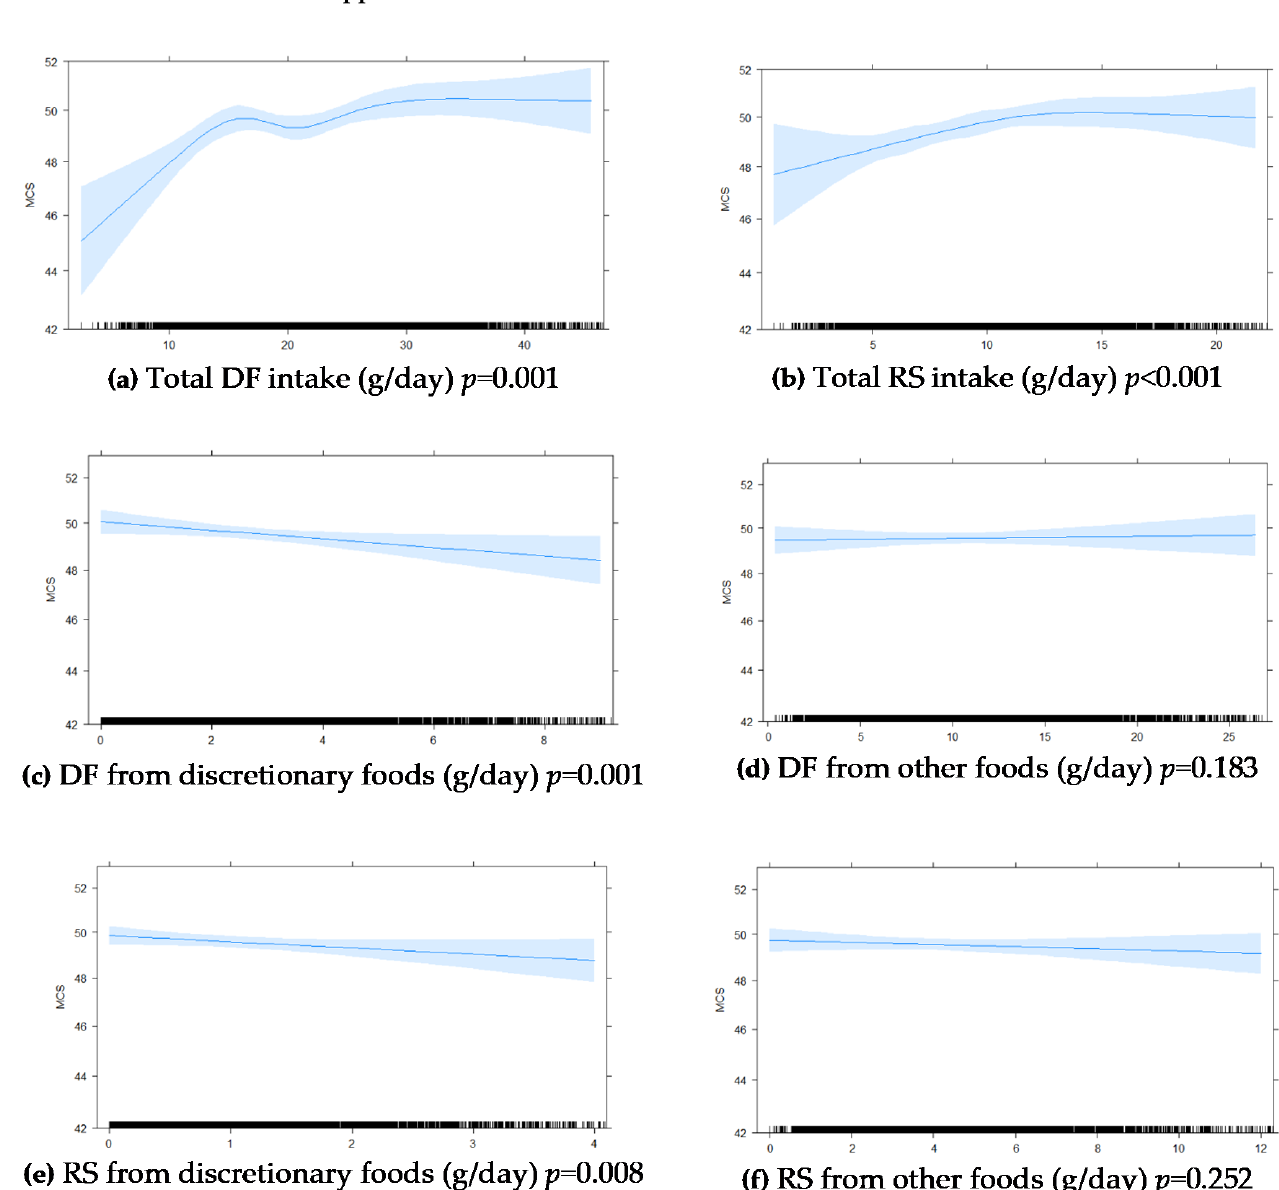
Figure A1. Graphic presentation from multivariable-adjusted general linear models of the longitudinal relationship between baseline intakes of ( a ) total DF, ( b ) total RS, ( c ) DF from discretionary foods, ( d ) DF from other foods, ( e ) RS from discretionary foods, ( f ) RS from other foods in (g/day), with 5 year MCS scores in 5845 Australian adults from the AusDiab study. Models were adjusted for age, sex, BMI, energy intake, relationship status, physical activity, level of education, the socio-economic index for areas (SEIFA), diabetes and self-reported prevalence of CVD. The blue shaded areas represent 95% CI, the rug plot along the bottom of each graph represents each dietary intake observation. DF, dietary fibre; FV, fruit and vegetables combined; MCS, SF-36 Quality of Life Scale—Australian norm-based mental component score median; RS, resistant